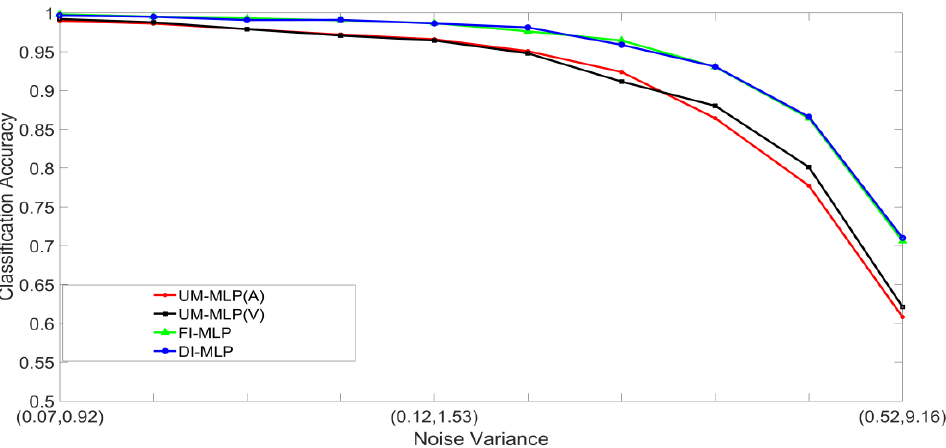
Figure 9. Classification accuracy, as a function of noise, and α = 0.9 in both stimuli, for the MLP-based classification systems.